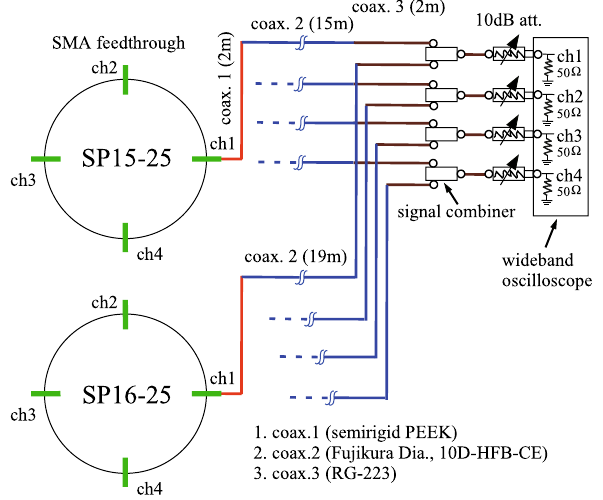
Figure 6. Simultaneous detection system for the two